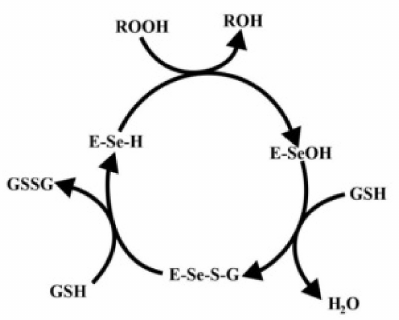
Figure 4. Catalytic mechanism of glutathione peroxidase. Based on